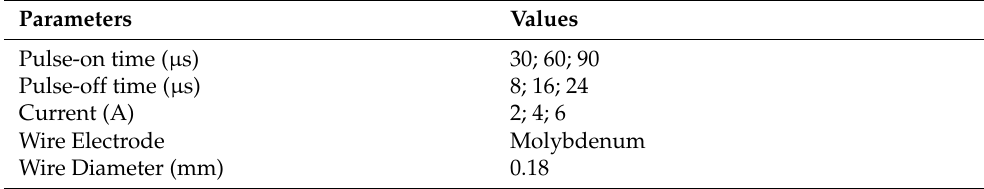
Table 1. Input factors of near-dry WEDM.